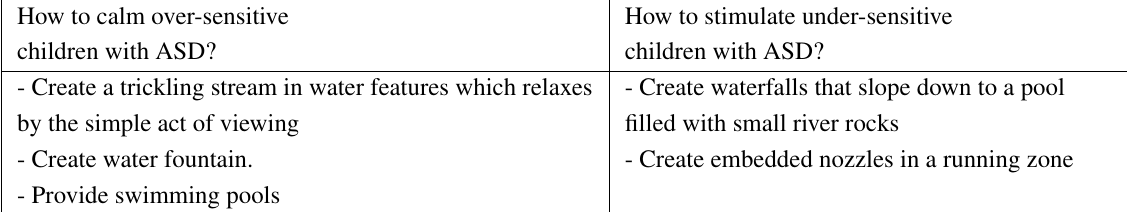
Table 16. How to use water features in creating specific influences (Wilson, 2006)